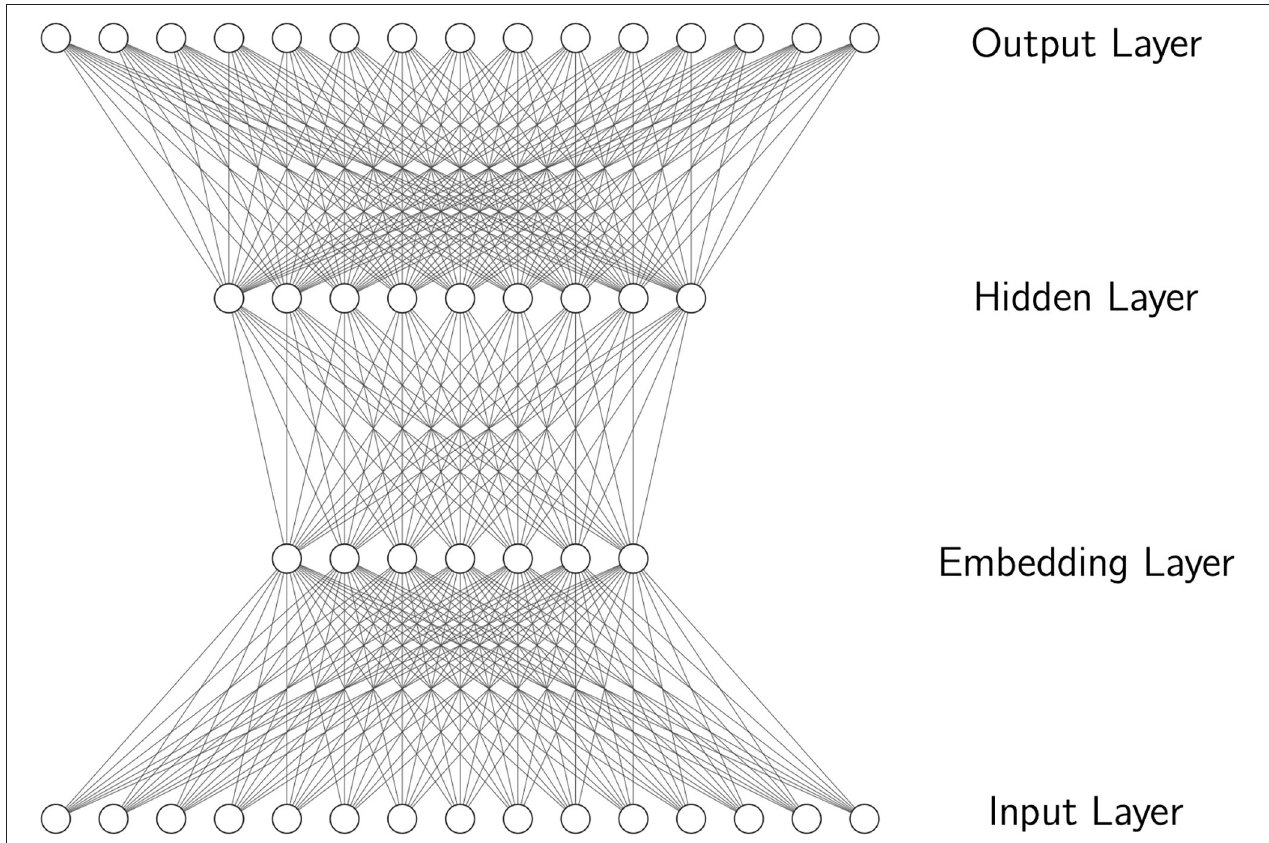
FIGURE 1 | A simple feedforward neural network with an input layer, an embedding layer, a hidden layer, and an output layer. This network can implement a bigram language model with units in the input and output layers representing different words in a vocabulary. When a word is active in the input layer, the unit with highest activation in the output layer is the model’s prediction for the next